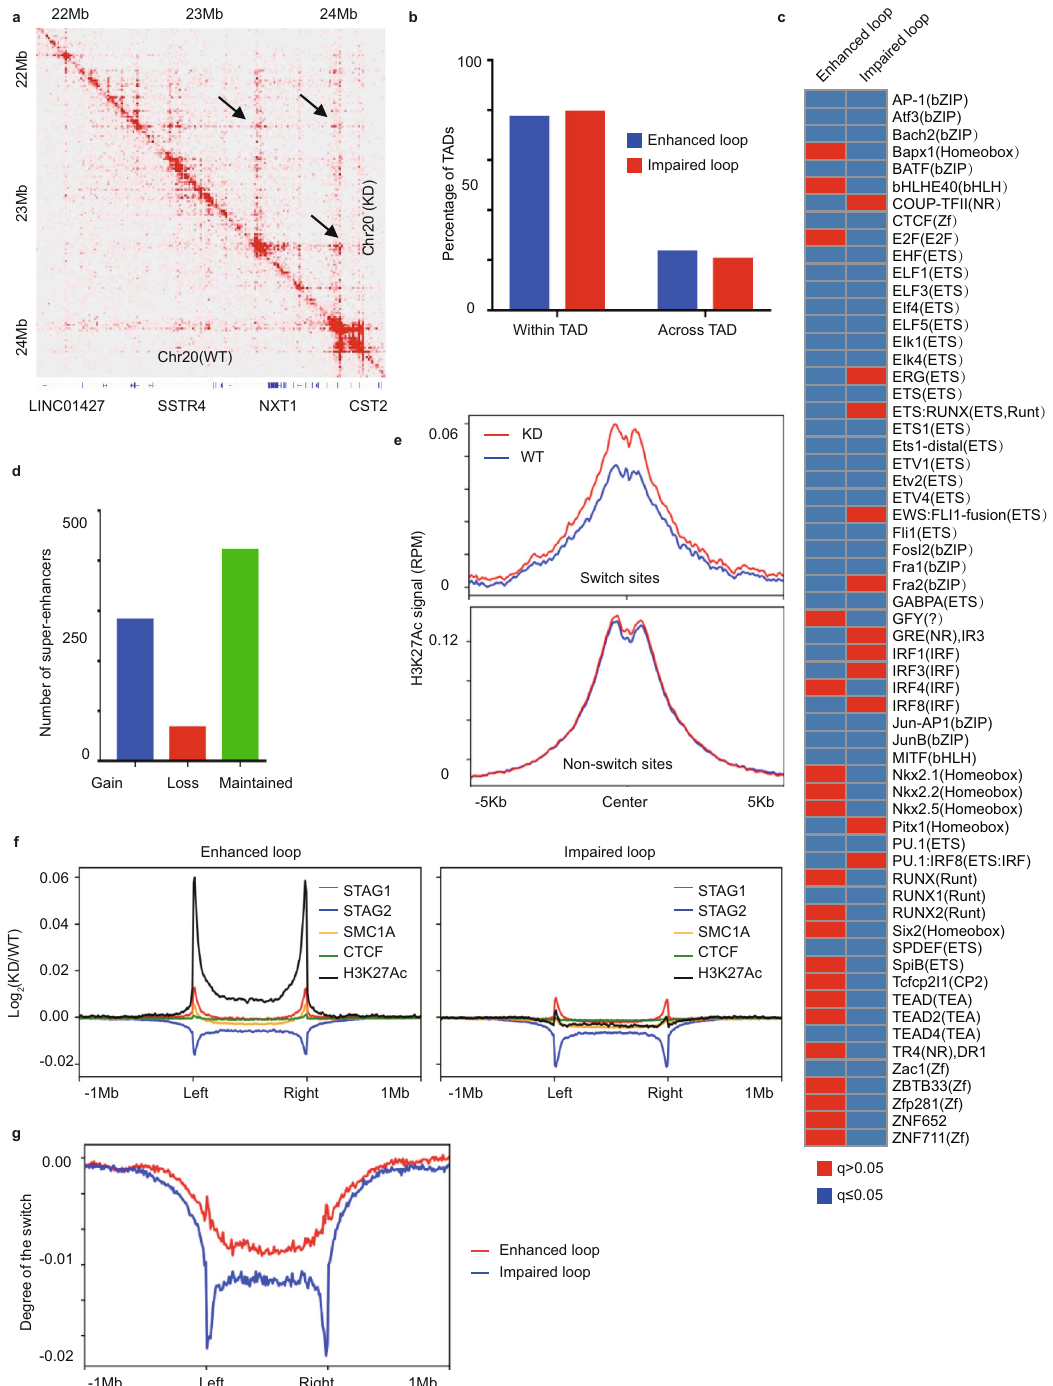
Fig. 2 STAG2 modulates the landscape of H3K27ac-associated loops. a Heatmap representation of differential H3K27Ac-associated loops between M14 cells with (KD) and without (WT) STAG2 shRNA knockdown as indicated by black arrows. b Majority of loop changes upon STAG2 knockdown occurs within TADs. c Motifs of transcription factors enriched at anchors of enhanced and impaired loops. d Numbers of gained, lost, and maintained super- enhancers upon STAG2 knockdown in M14 cells. e Gain of H3K27ac signal at the STAG2 to STAG1 switch sites, but not non-switch sites, upon STAG2 knockdown. f Differential CTCF, SMC1A, STAG1, STAG2, and H3K27ac pro fi les at anchors of enhanced and impaired loops upon STAG2 knockdown. g The relative gain of STAG1 in compensation to the loss of STAG2 is signi fi cantly higher at anchors of enhanced loops than those of impaired loops. The degree of the switch is calculated as the sum of log 2 (KD/WT) for STAG1 and STAG2